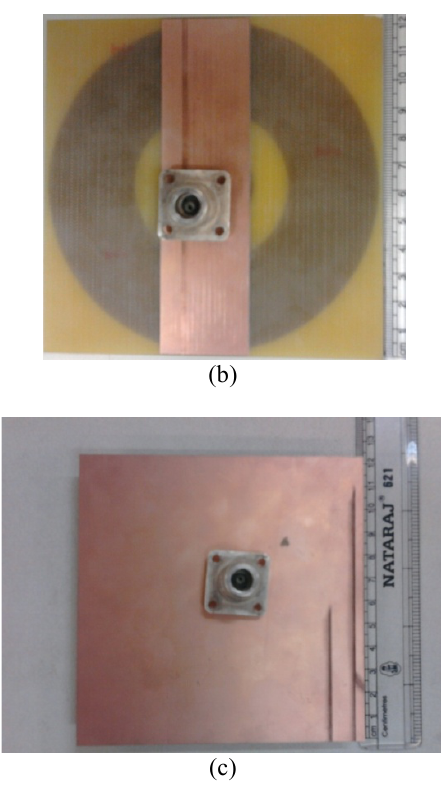
Figure 2. Multiple ring gap coupled DGS microstrip antenna design for experiment(a) top view (b) bottom view (with defect) (c) bottom view (without